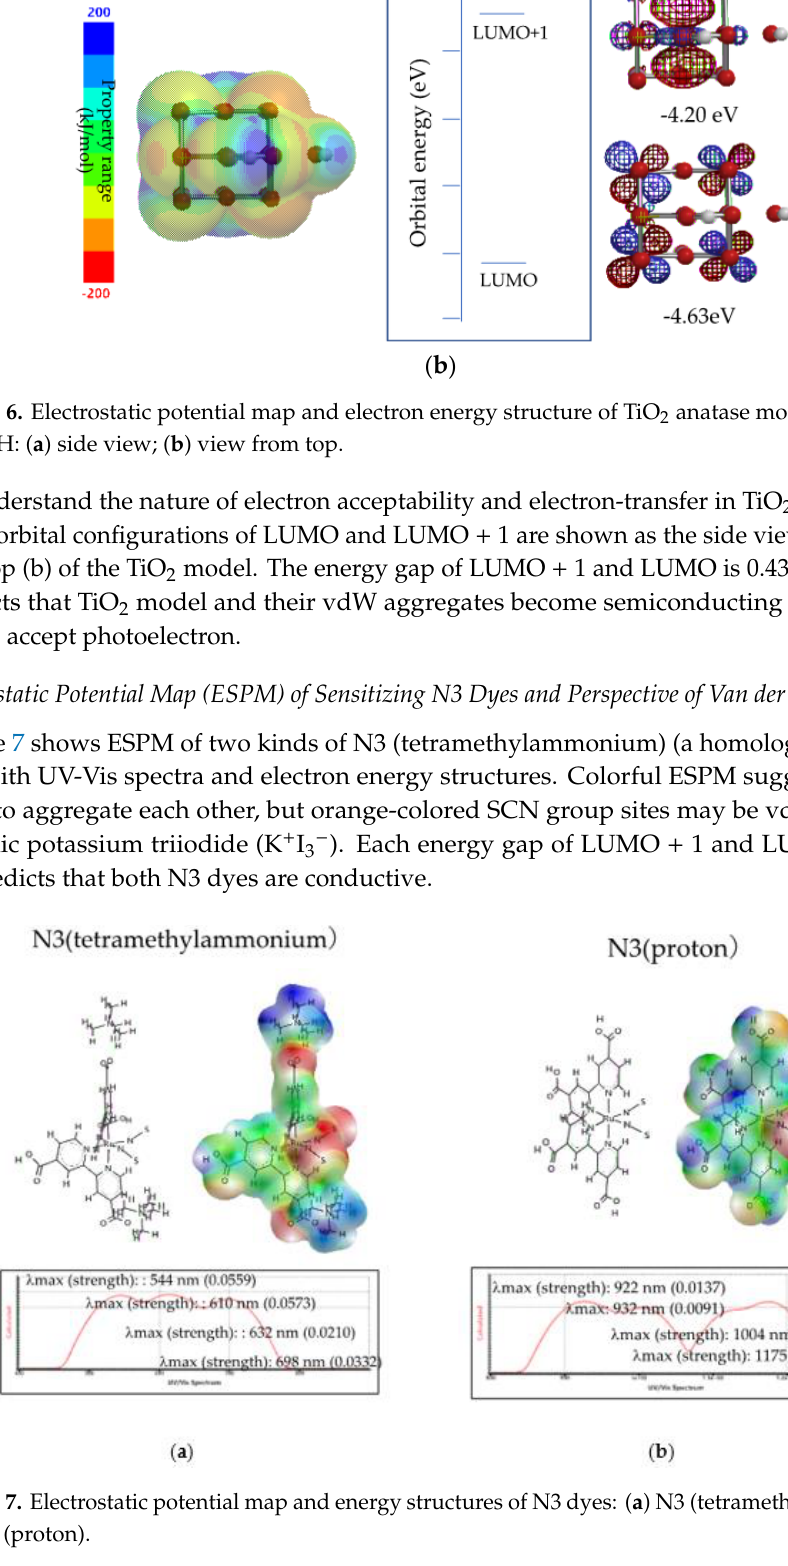
Figure 7. Electrostatic potential map and energy structures of N3 dyes: ( a ) N3 (tetramethylammonium); ( b ) N3 (proton).